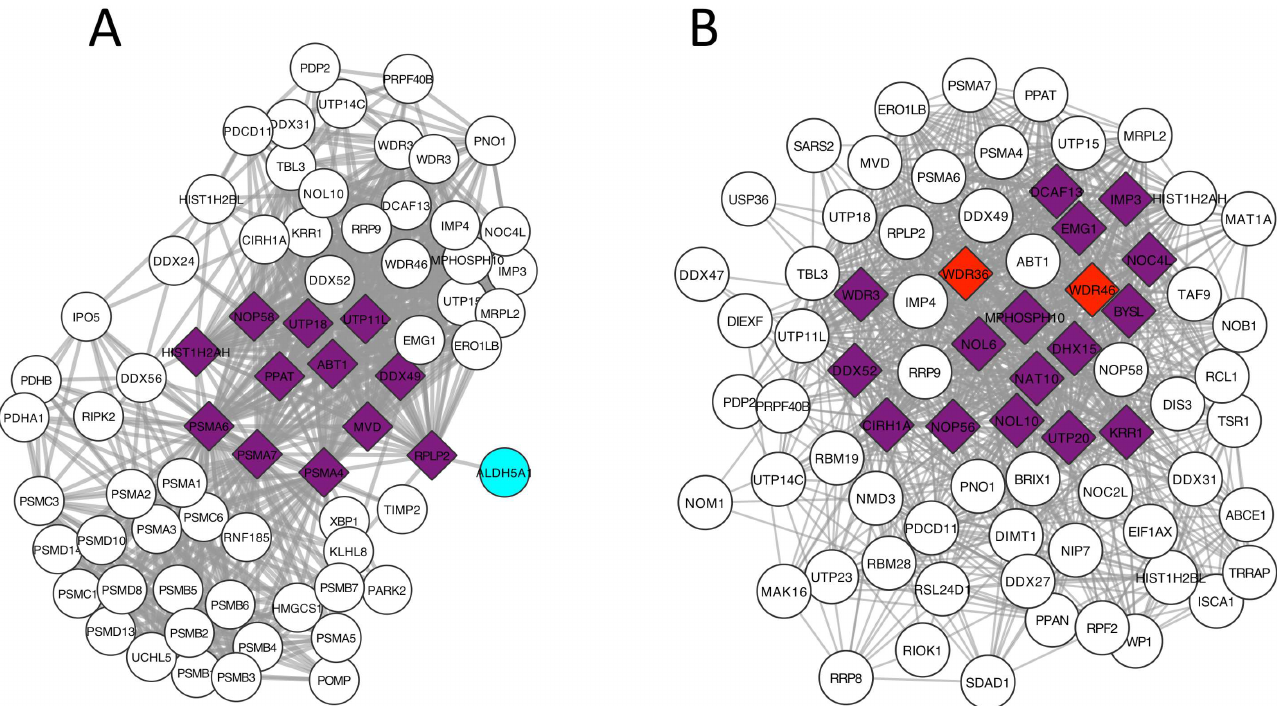
Fig 3. Results of Hotnet2 and Conflux on clique-shaped disease subnetworks where the disease genes are part of an even larger clique. (A) Causalsubnetworkcontainsa third of the genesin the clique;(B) Causalsubnetworkis half of the genesin the largest clique.The nodesin purple are genes found by both Hotnet2 and Conflux.The nodes in cyan were only found by Hotnet2. The nodesin red and pink are respectivelynodesdetected (marginal (cid:21) 0.2) or havingsuggestiveevidence(marginal (cid:21) 0.05) by Conflux. Nodes coloredin plum were found by Hotnet2 but only have suggestive evidencein Conflux. The diamondshaped nodesare the true causal genes. The sample size used is n = 800.